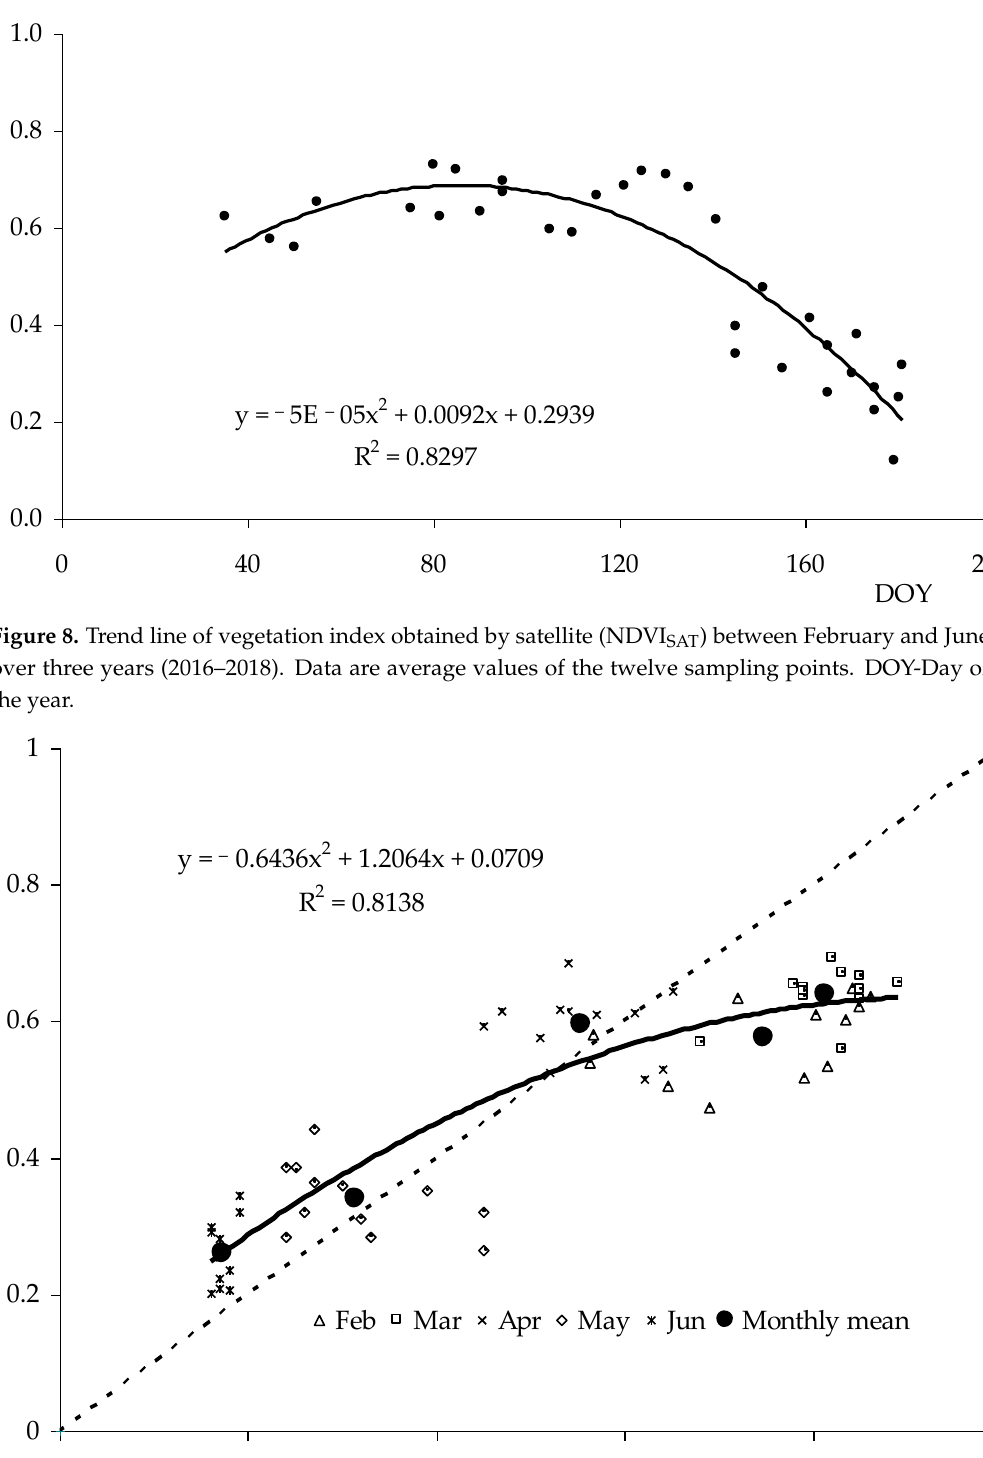
Figure 9. Correlation between vegetation index values obtained by proximal sensor (NDVI PS ) and those obtained by satellite (NDVI SAT ), in the set of monthly sampling dates (between February and June 2017). The dotted line corresponds to the perfect correlation (R 2 = 1).